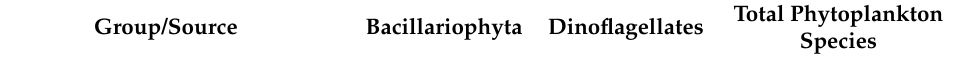
Table 6. Total numbers of phytoplankton species and main groups in Alexandria coast during different